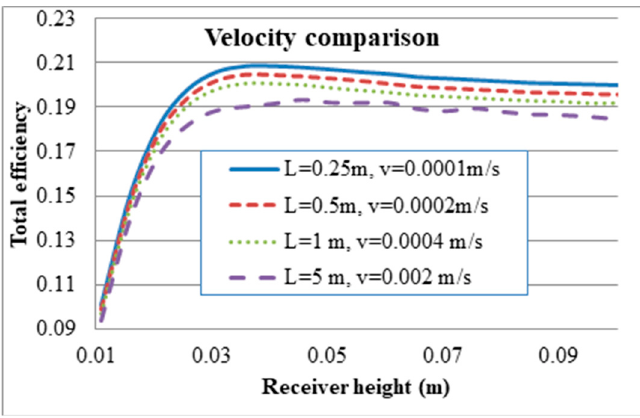
Figure 15. Inlet velocity comparison at different receiver lengths and heights.